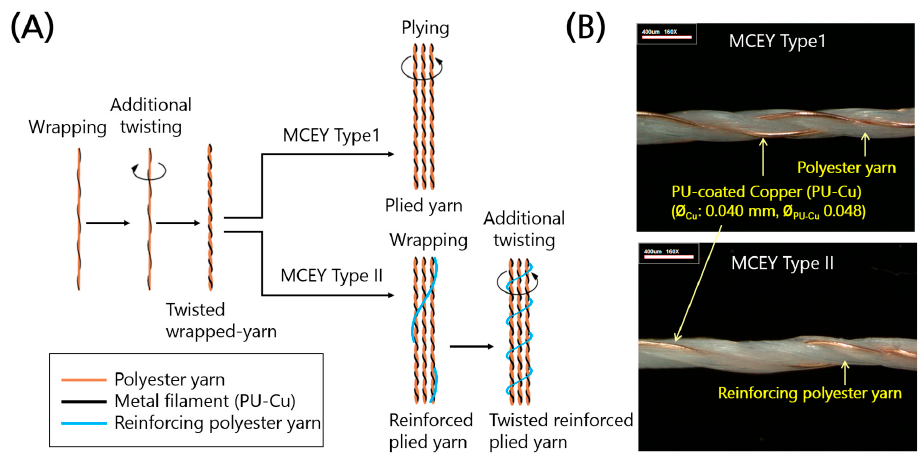
Figure 3. Development of conductive yarn. ( A ) Illustration of yarn manufacturing process for MCEY Types 1 and 2. ( B ) Lengthwise images of insulated MCEY (PU-Cu). Yarn Type 1 is a plied yarn of three strands of twisted wrapped yarn, and Yarn Type 2 is a twisted reinforced plied yarn of reinforcing polyester yarn wrapped around three strands of twisted wrapped yarn.